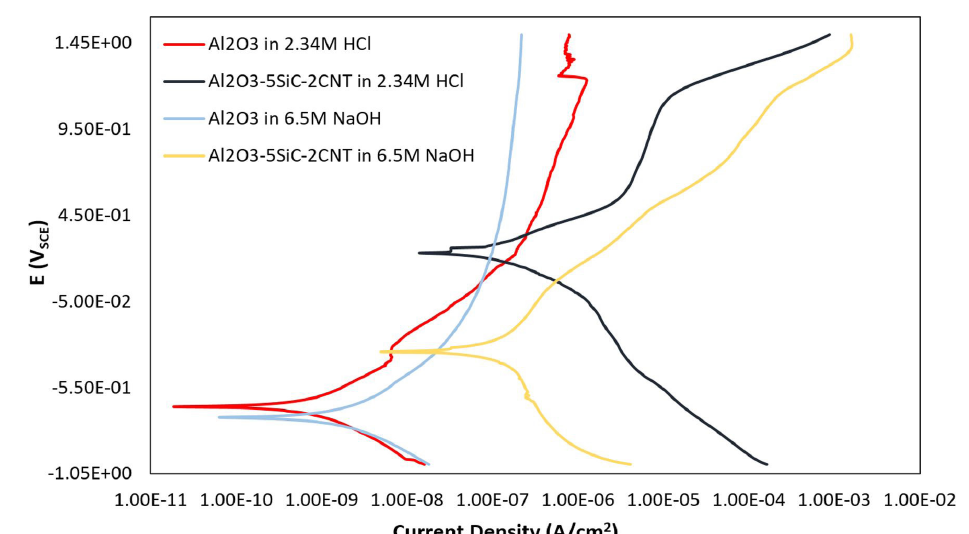
O and Al O -5SiC-2CNT nanocomposite ‎samples. 2 3 2 3